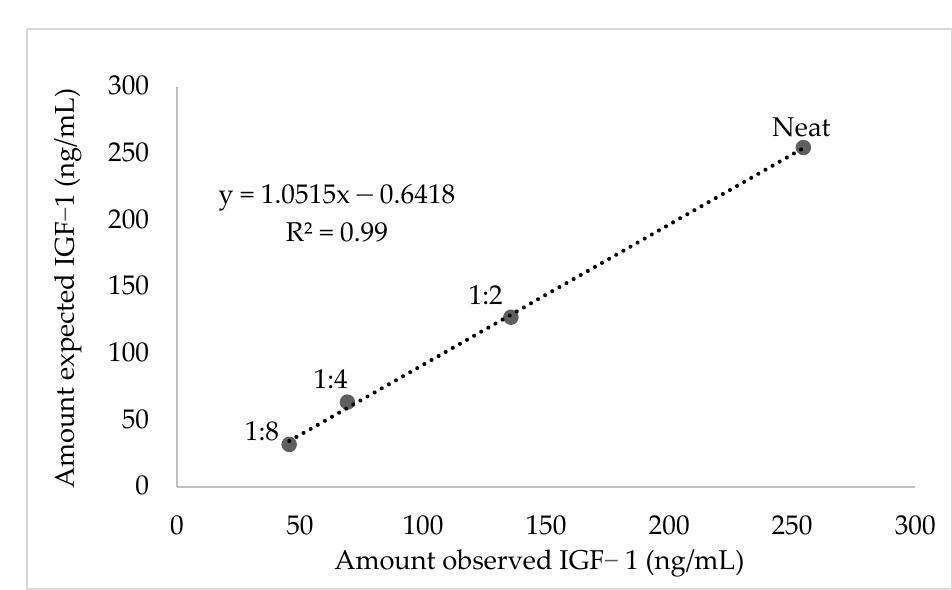
Figure 1. Investigated linearity through a serial dilution of one serum sample to demonstrate an